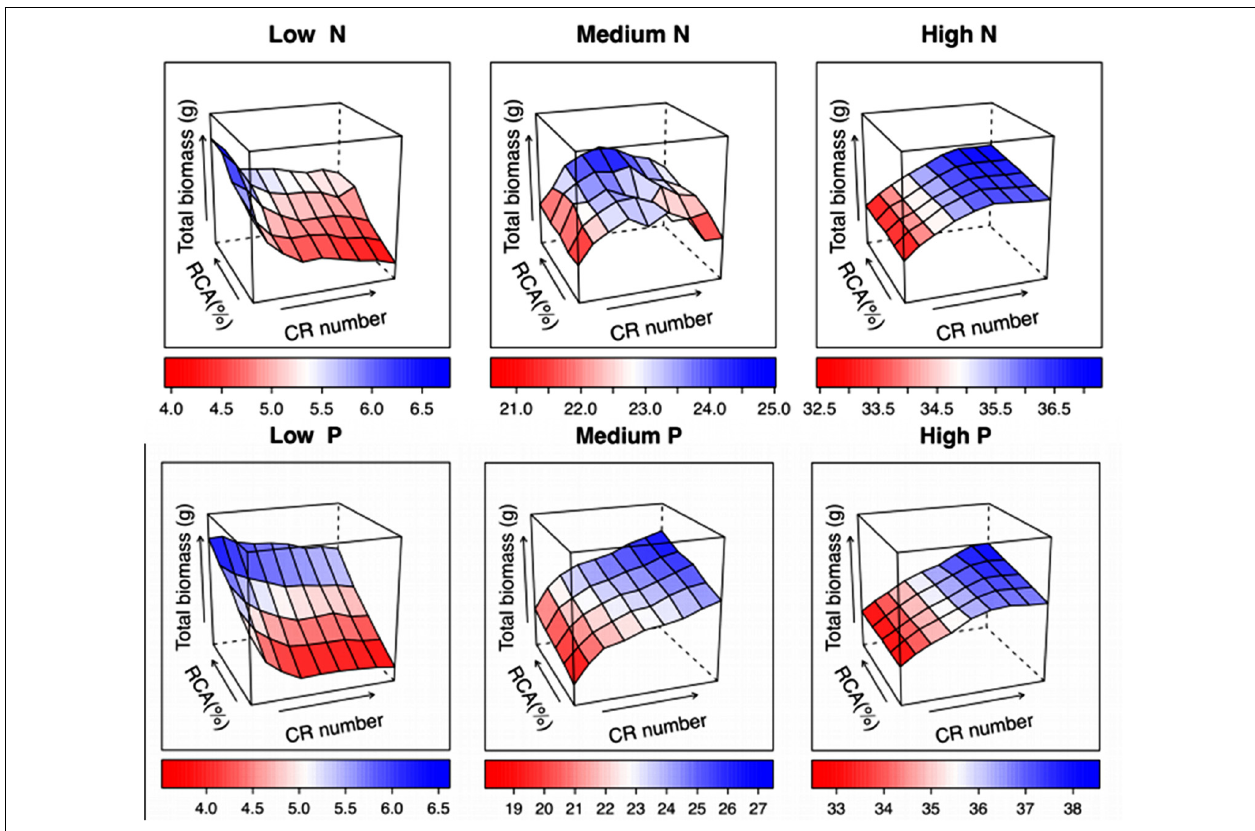
FIGURE 7 | Phene integration of root cortical aerenchyma (RCA) and crown root (CR) number was studied in maize using SimRoot across a range of nitrogen (N) and phosphorus (P) levels. These simulation results demonstrate linear, asymptotic, and optimum single phene responses and their interactions.